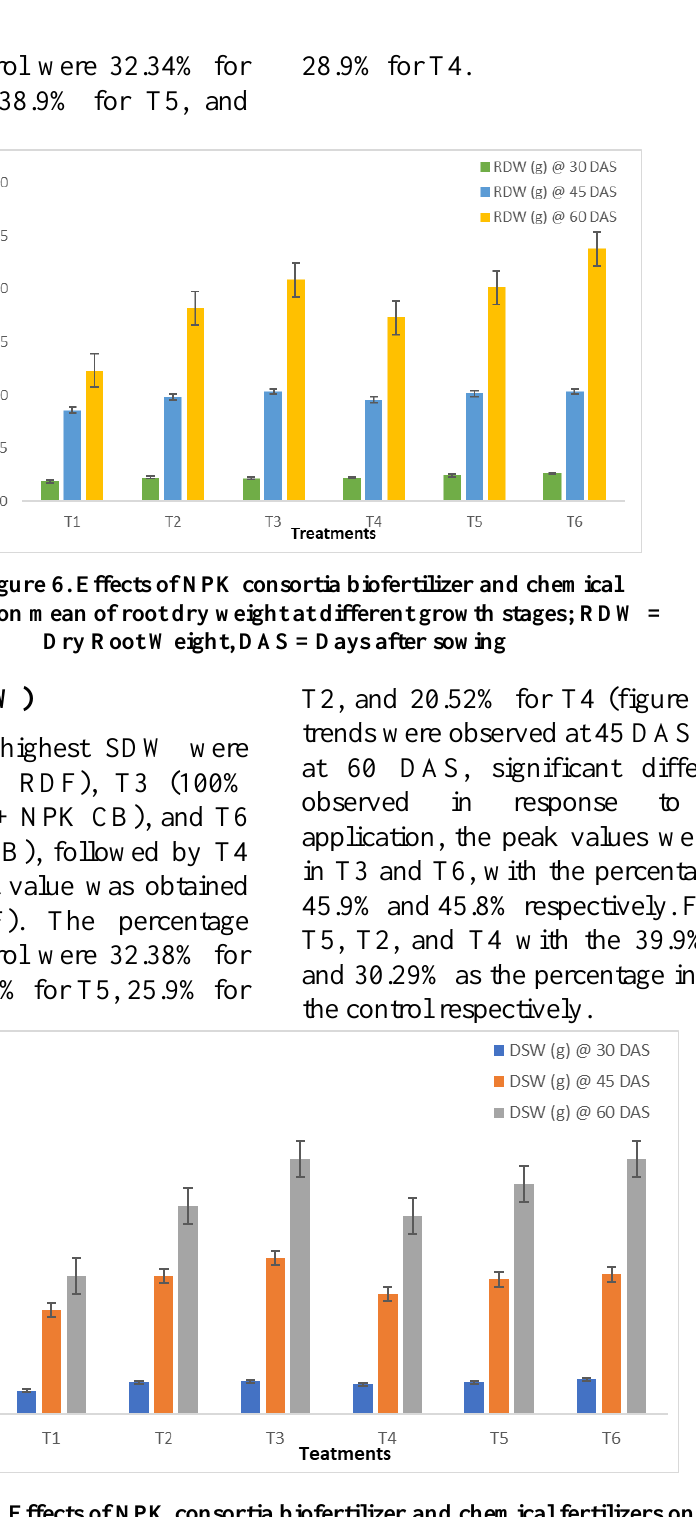
Figure 7. Effects of NPK consortia biofertilizer and chemical fertilizers on mean of shoot dry weight at different growth stages; SDW = Shoot Dry Weight, DAS = Days After